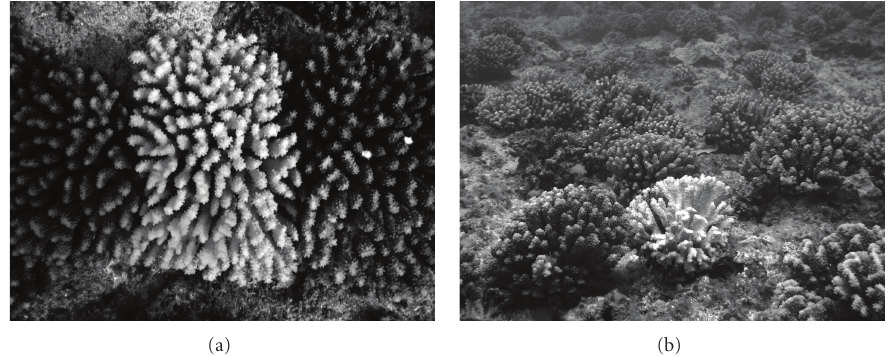
Figure 1: Microspatial heterogeneity in degree of coral bleaching seen in Pocillopora sp. (photograph by K. Gorospe) (a) and P. meandrina (photograph by K. Tice) (b) on a reef at Kure Atoll,